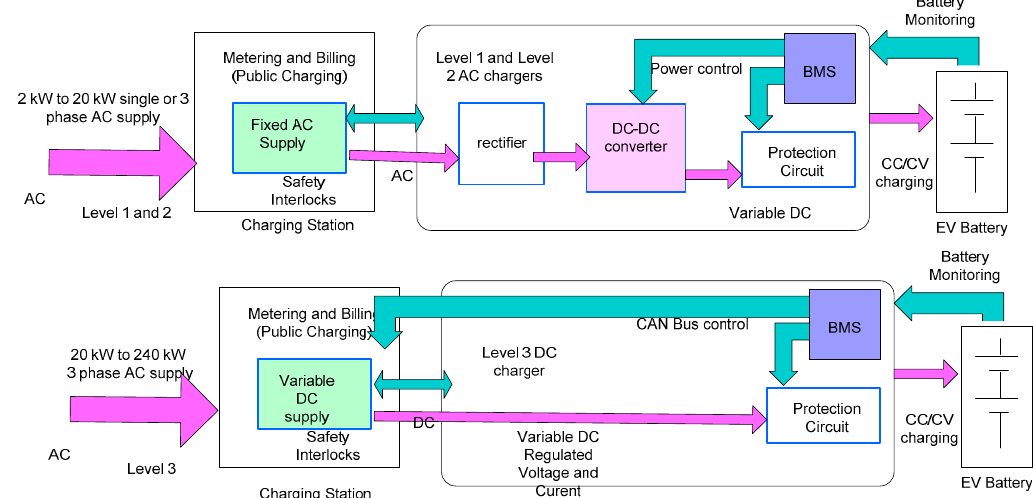
Figure 2. Block diagram of different types of charging systems.